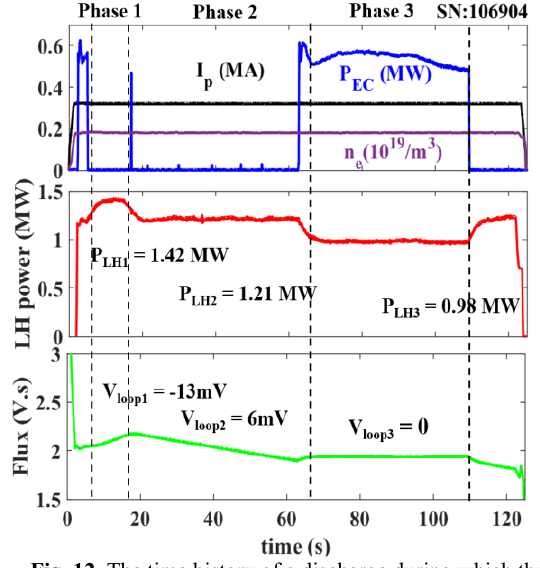
Fig. 12. The time history of a discharge during which the synergy effect between LHCD and ECCD is observed.